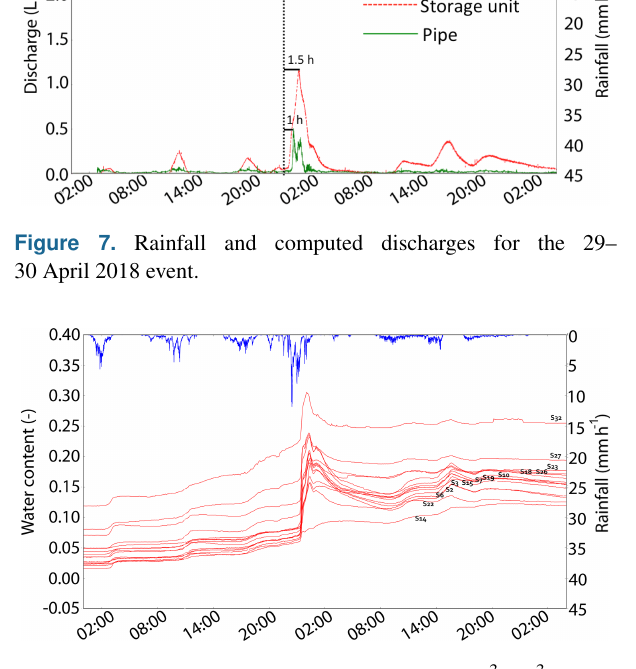
Figure 8. Rainfall and volumetric water content (m 3 m − 3 ) for 16 TDR sensors for the 29–30 April 2018 event (sensor references are indicated by an increasing value at the end of the